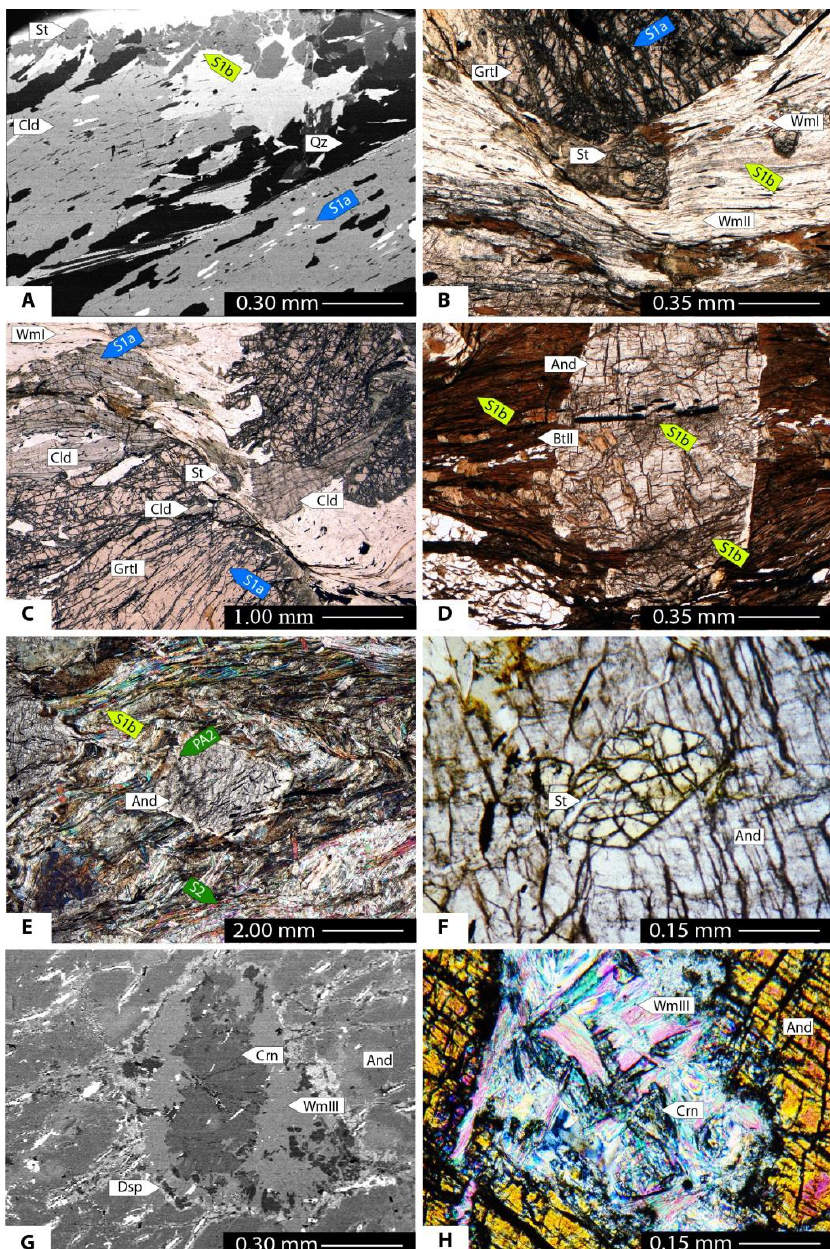
Figure 7. Variscan metapelites. ( A ) S1a supported by shape-preferred orientation of millimeter-sized chloritoid porphyroblasts (BSE image). Internal foliation in chloritoid is continuous with external S1a. S1b is supported by submillimeter sized staurolite grains and cuts S1a. ( B ) Porphyroclast of GrtI wrapped by S1b. S1b is marked by WmII and BtII. GrtI retains a straight internal foliation discontinuous with the external one. Staurolite in the strain caps around GrtI encloses deflected S1b (PPL image). ( C ) S1a supported by chloritoid. Chloritoid is included in GrtI, and the internal foliation in both GrtI and chloritoid is deflected but continuous with the external foliation S1a. Chloritoid grains are boudinaged and staurolite grew in the boudin-neck (PPL image). ( D ) Andalusite with internal foliation continuous with external S1b: the internal foliation is straight at the grain core and curved at the rim. S1b is marked by BtII. Decussate grains of biotite are preserved in cleavage domains and as inclusions in andalusite (PPL image). ( E ) Post-kinematic andalusite porphyroblast overprints D2 folds (PPL image). ( F ) Andalusite porphyroblast includes staurolite with equilibrium grain boundaries (PPL image). ( G , H ) Andalusite porphyroblasts include corundum grains and are replaced by diaspore and WmIII (BSE and XPL images).